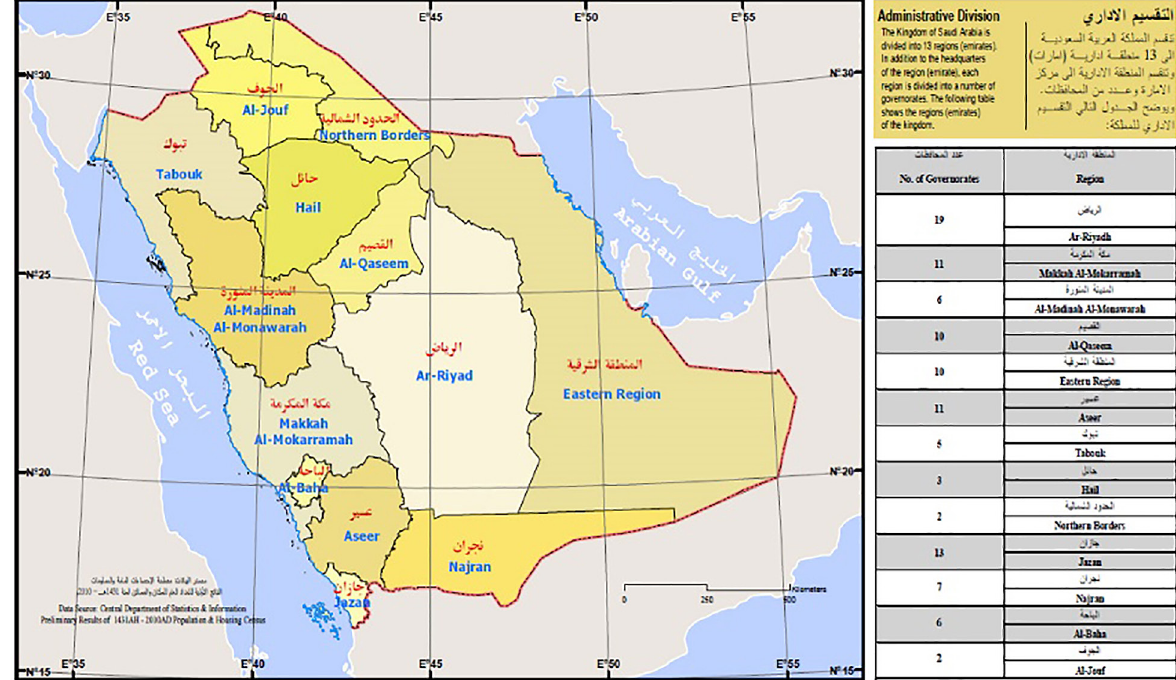
Fig. 1. Map of the regional administrative division of Saudi Arabia. Source: Makkah Province municipality